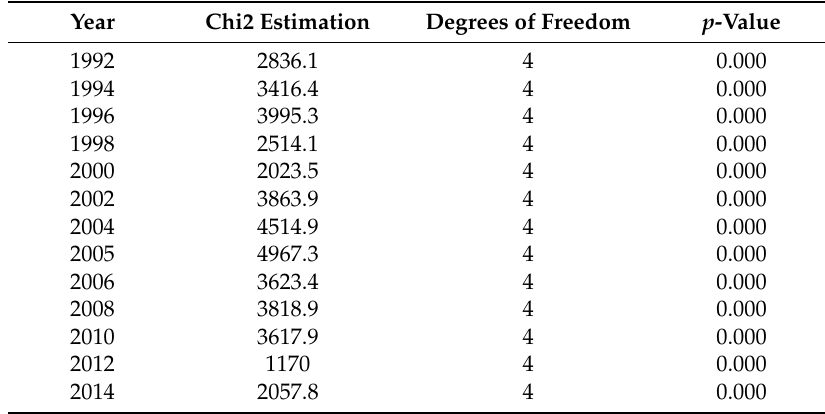
Table A3. Results of Kruskal-Wallis equality-of-populations rank test for electricity consumption and consumer practices latent